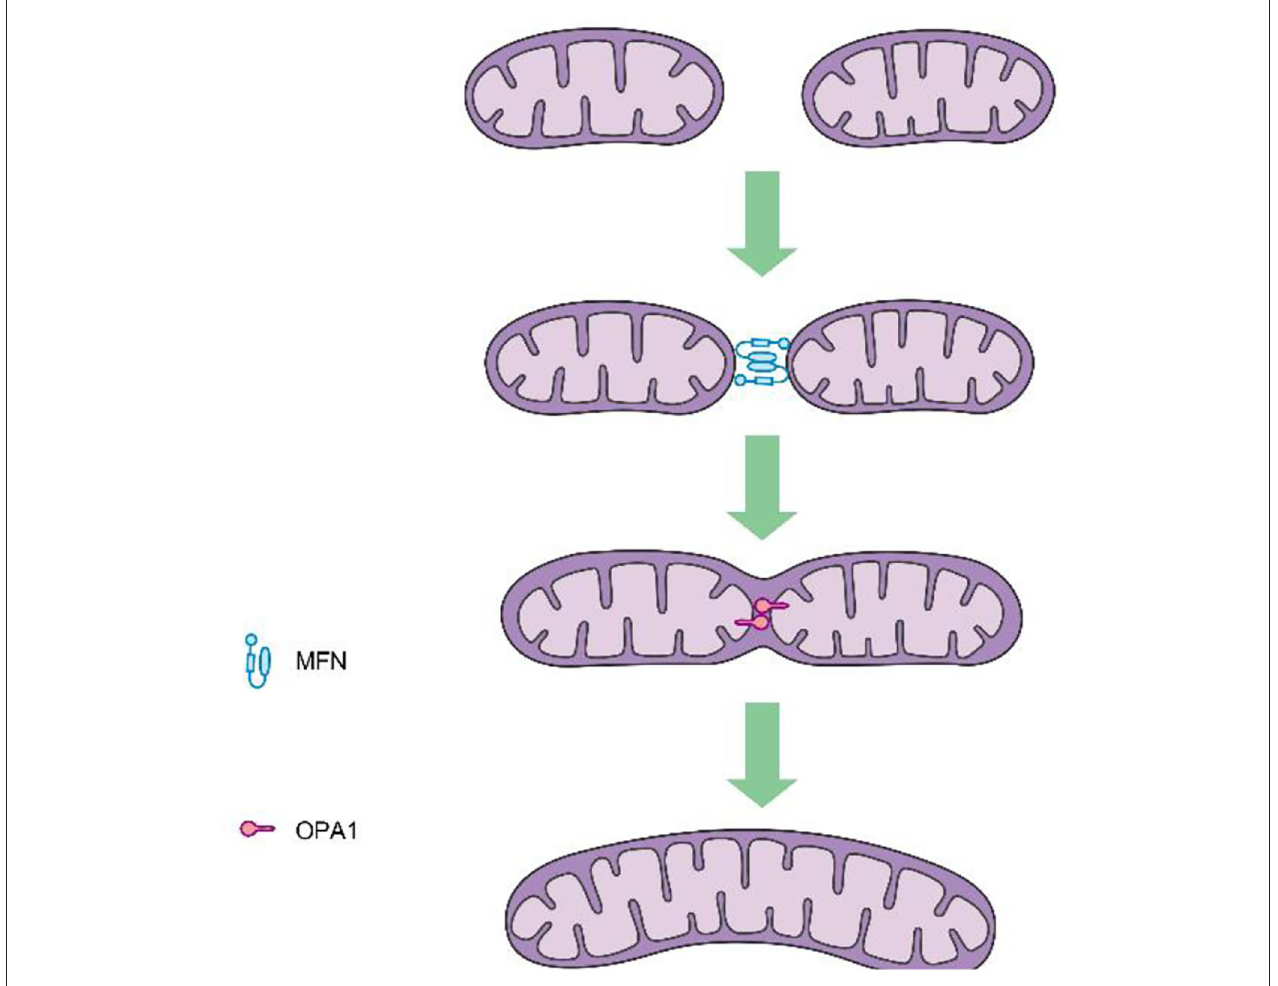
FIGURE 2 | Procedures of mitochondrial